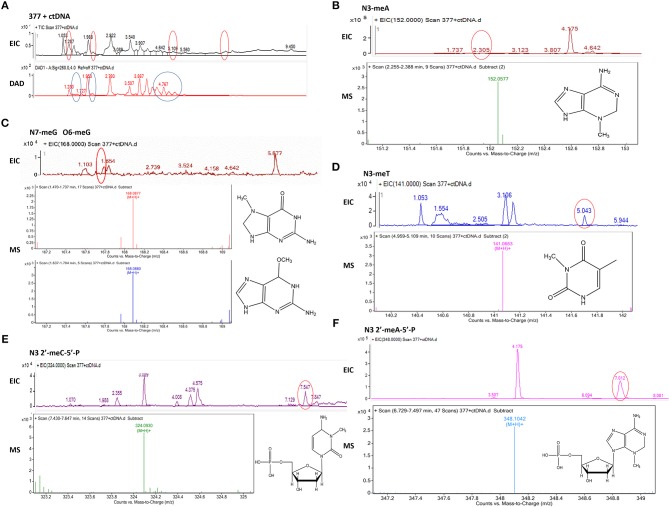
Mass spectra of 377. The incubation of 377 with ctDNA for 24 h followed by enzymatically digestion with benzonase and nuclease S1. (A) Total ion chromatogram of 377 with ctDNA. (B) Mass spectra of N3-methyladenine (C6H9N5) at m/z 152.0577. (C) Mass spectra of N7-methylguanine and O6-methylguanine (C6H9N5O) at m/z 168.0877 and 168.087. (D) Mass spectra of N3-methylthymine (C6H8N2O2) at m/z 141.0663 141. (E) Mass spectra of N3-methylcytidine deoxynucleotides (C6H18N3O7P) at m/z 324.0930. (F) Mass spectra of N3-methyladenine deoxynucleotides (C11H18N5O6P) at m/z 348.1042.